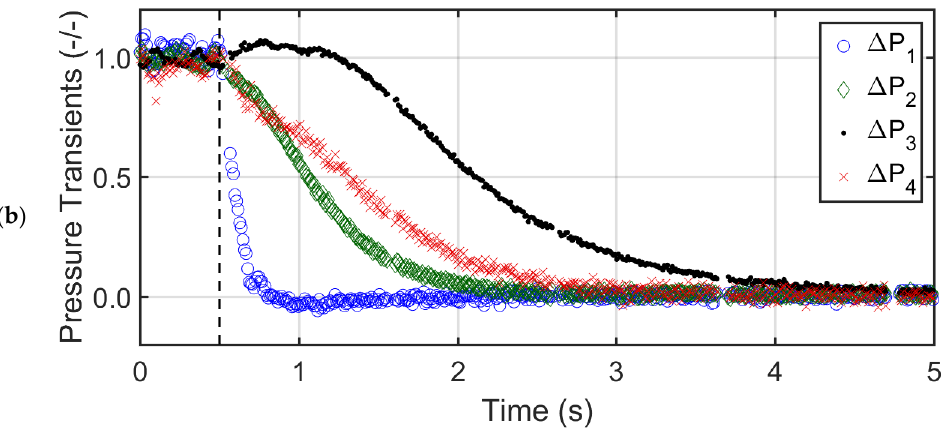
Figure 6. Pressure drop transients in different regions of the bed of titania powder for ( a ) 𝑈 0 = 𝑈 𝑚𝑓 , ( b ) 𝑈 0 = 2𝑈 𝑚𝑓 .